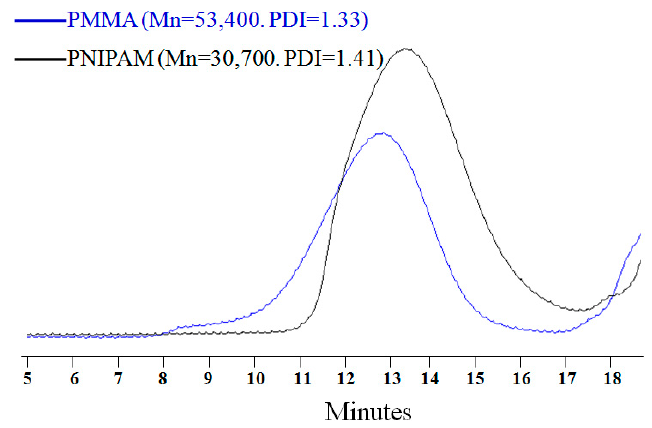
Figure 4. Gel permeation chromatography (GPC) traces of PMMA and PNIPAM.